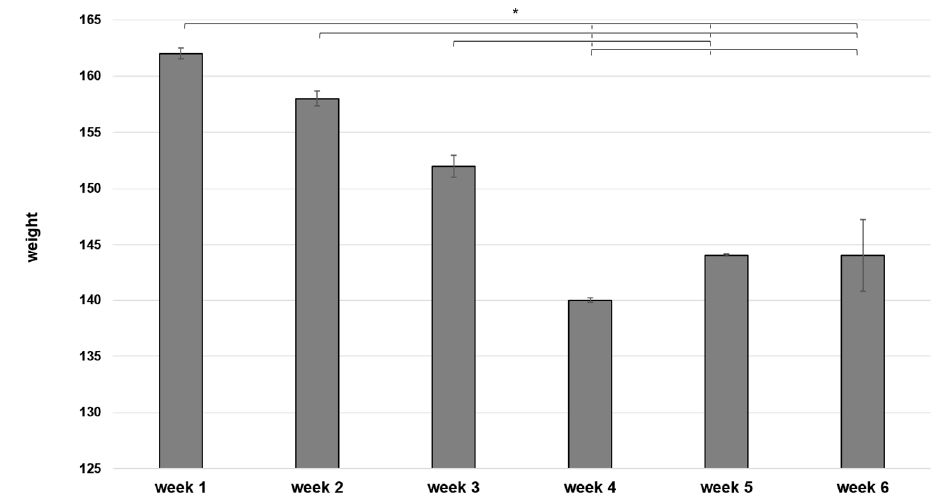
Figure 5. Trend of Eurasian Hobby’s weight during the high-tech training. Median value ± standard error representing the trend of the weight for the wild falcon ( F. subbuteo ) during the habituation phase. Wilcoxon test for non-parametric data, results are given as a range * W = 0, p < 0.001.